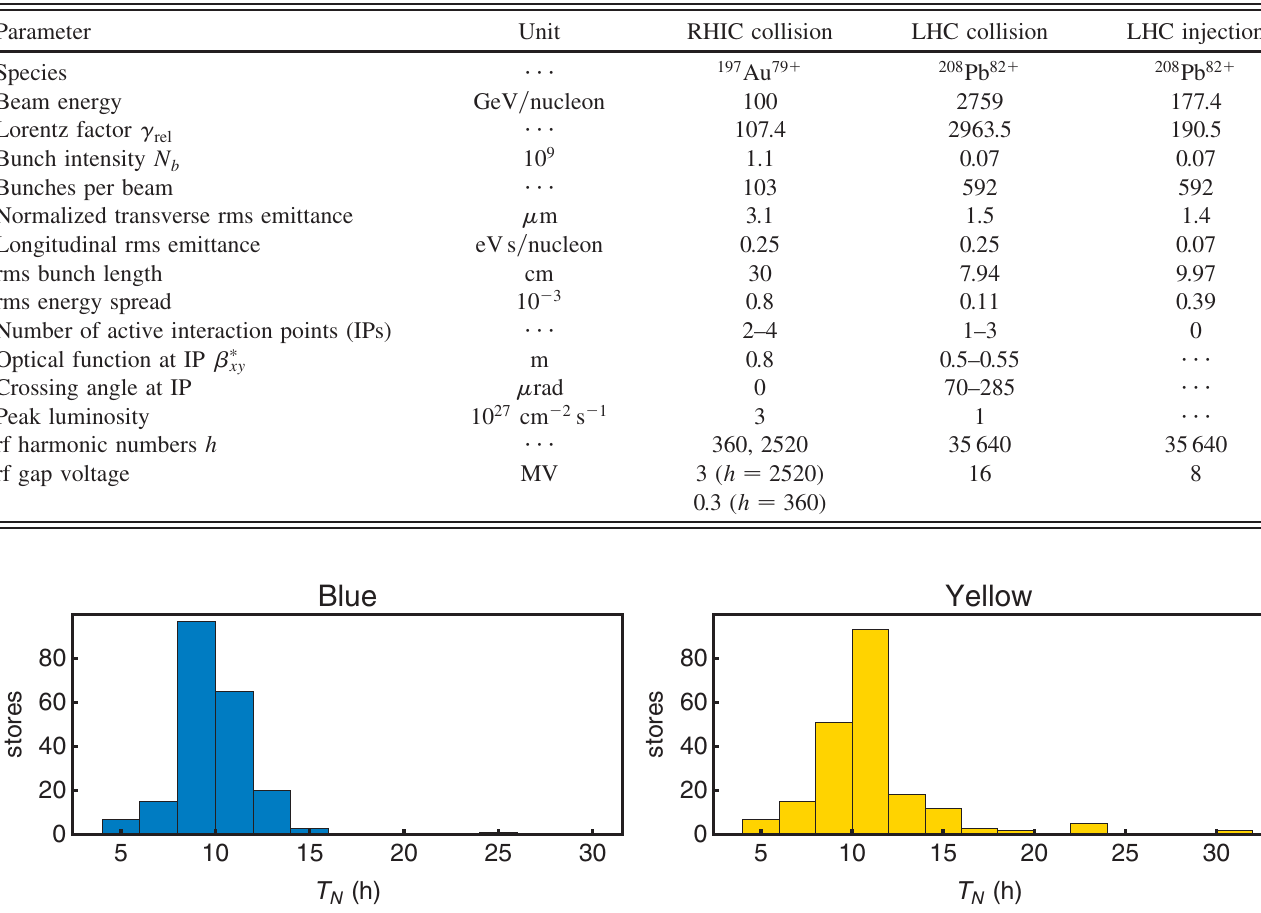
TABLE I. Typical beam and machine parameters for RHIC run-7 and the LHC, given for the beginning of store. The transverse emittance in RHIC showed large variations between stores [14].